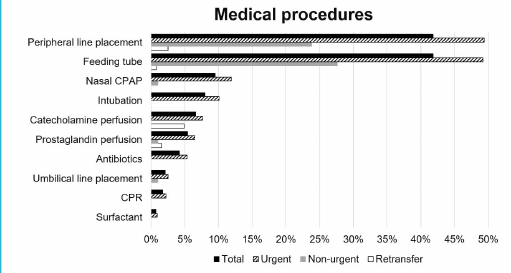
Figure 2: Medical procedures performed by neonatal transport teams during transport runs. CPAP = continuous positive airway pressure; CPR = cardiopulmonary resuscitation